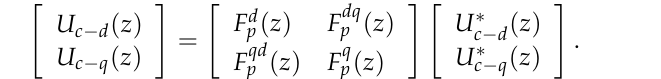
Figure 9. ( left ) Pole-zero diagram of (grey) the uncompensated plant in Equation (15) ( w (cid:48)(cid:48) input and u c − d [ k ] is the output) and (black) the compensated plant, F d p ( z ) . ( right ) Bode diagram of (grey) the uncompensated plant and (black) the compensated